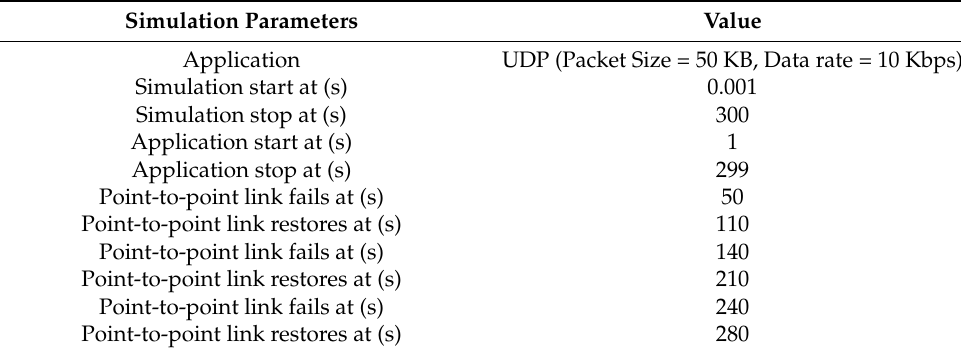
Table 2. Some of the key simulation parameters for the SCN. Simulation